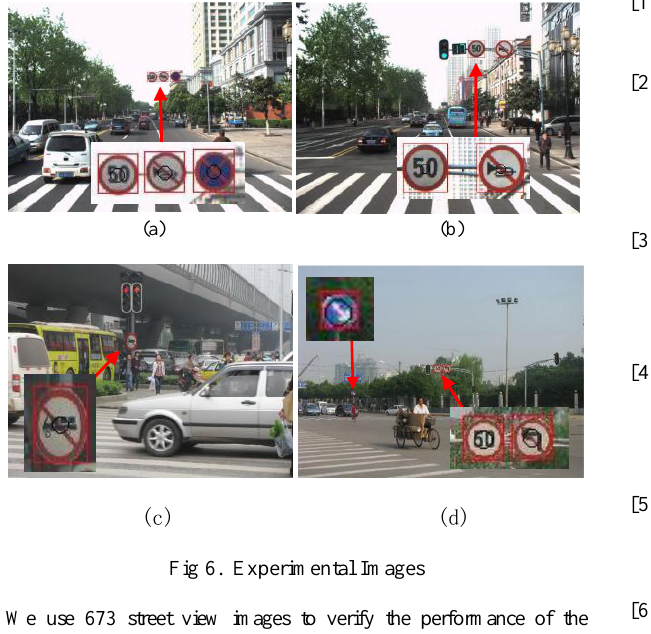
Fig 6. Experimental Images